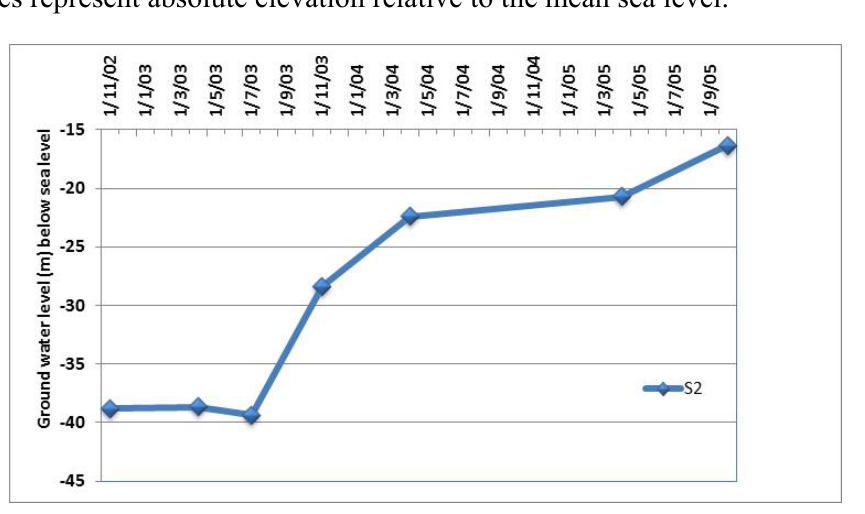
Figure 9. Groundwater level fluctuation in the S2 monitoring well located in the Sindos area. Values represent absolute elevation relative to the mean sea